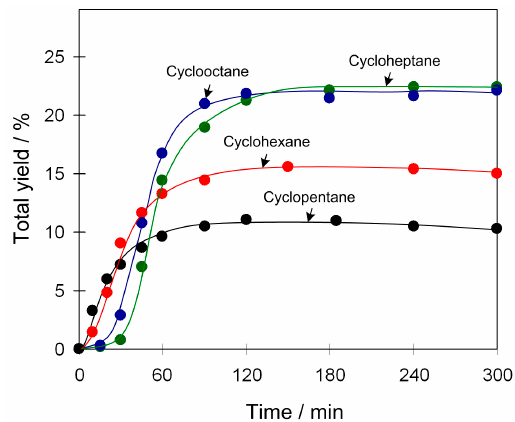
Figure 4. Substrate scope in oxidation of cyclic C 5 –C 8 alkanes with H 2 O 2 to corresponding ketones and alcohols (total product yield vs. reaction time) catalyzed by 1 . Conditions: 1 (0.005 mmol), C 5 H 10 –C 8 H 16 (1.0 mmol), H 2 O 2 (50% in H 2 O, 5.0 mmol), PCA (0.015 mmol), CH 3 CN (solvent added